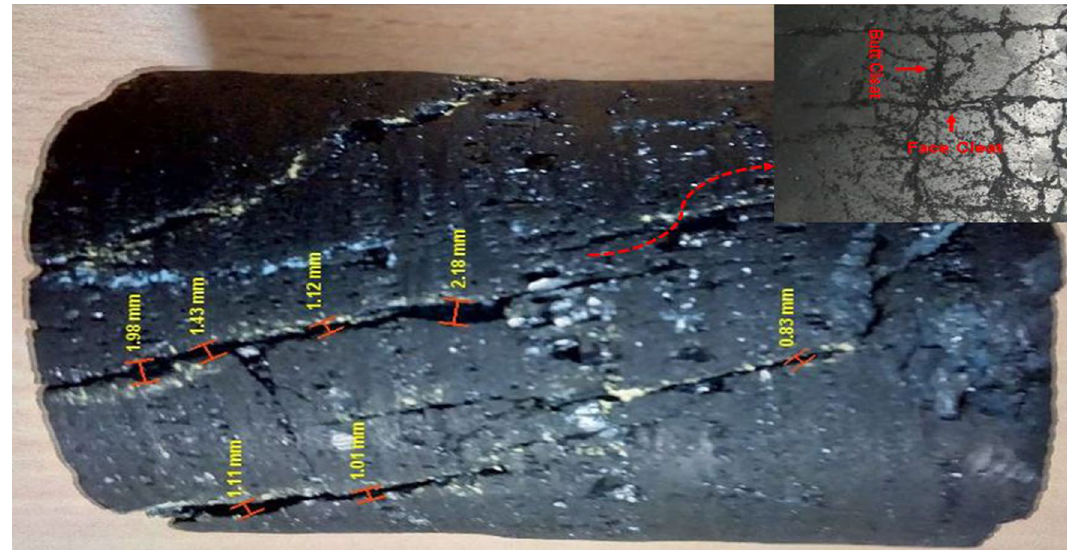
Fig. 14 Cleat network in intact coal sample